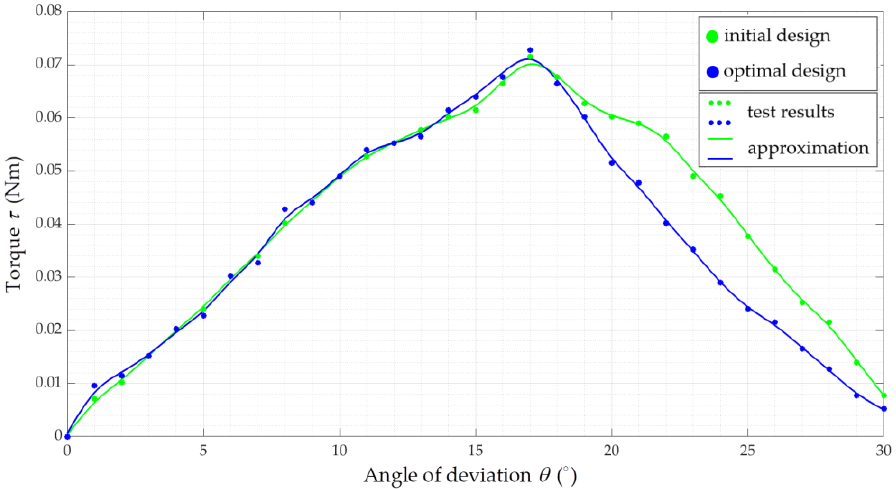
Figure 14. Test results for the initial and optimal designs of the coupling.